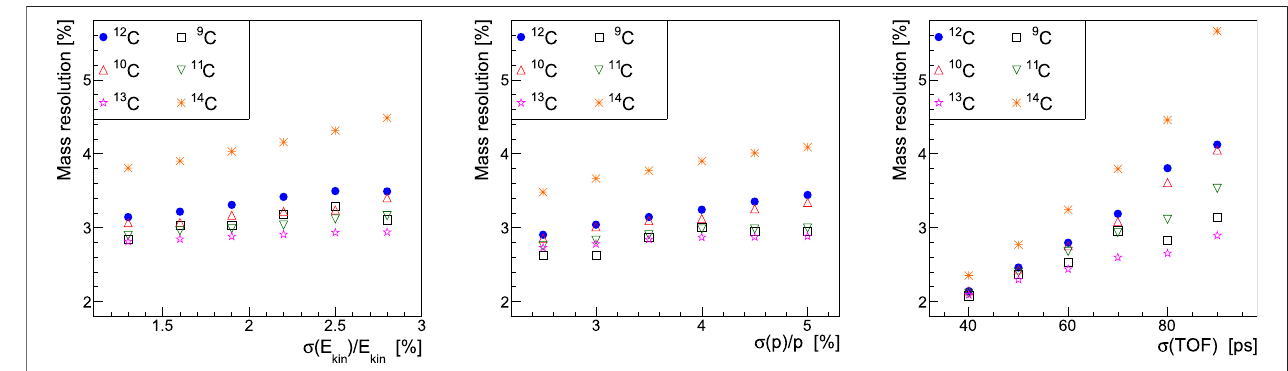
FIGURE9| Massresolutionoftheidenti fi edisotopes ofcarbon ions( 9 C, 10 C, 11 C, 12 C, 13 C, 14 C)asafunctionof:A)kineticenergy resolution( σ ( TOF ) (cid:2) 70psand σ ( p ) / p (cid:2) 3 . 7 % ) B) momentum resolution ( σ ( TOF ) (cid:2) 70ps and σ ( E